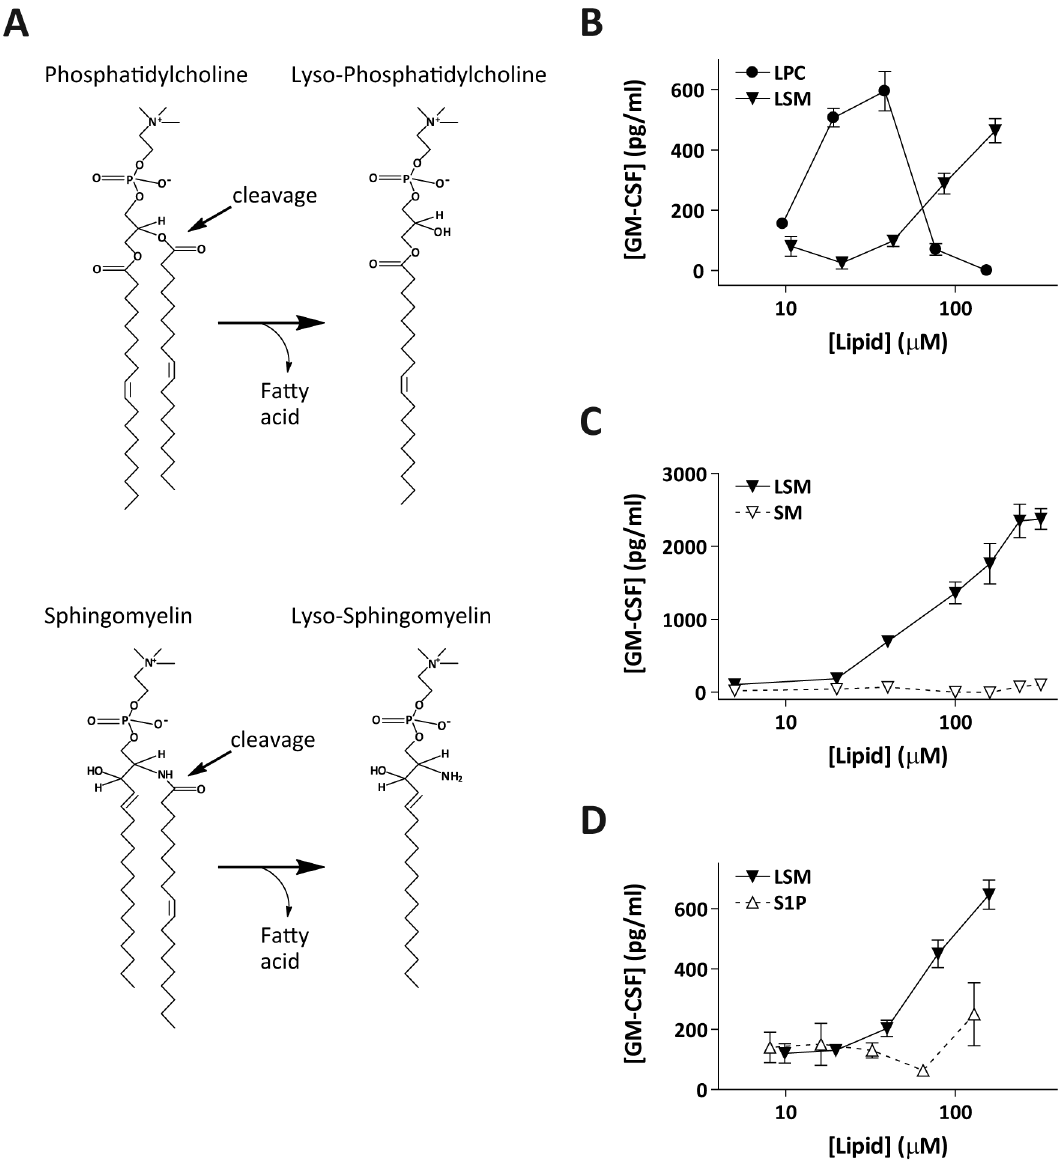
Figure 4. Molecular specificity of NKT cell recognition. (A) Chemical structures of di-C18:1 PC and SM, and their lyso derivatives LPC and LSM. (B) Response of NKT cell clone J3N.5 to CD1d molecules pulsed with the indicated concentrations of LPC or LSM. One representative experiment out of five is shown. Similar results were observed with two other NKT cell clones. (C) Only the lyso- form of sphingomyelin appears markedly antigenic for NKT cells. The results shown are from one representative experiment out of two using clone J3N.5. Similar results were observed with two other NKT cell clones. (D) Sphingosine-1-phosphate (S1P), which is identical to LSM except that it lacks the choline head group, was not recognized. Results shown are from one representative experiment out of three using clone Jc2.7. Similar results were observed with two other NKT cell